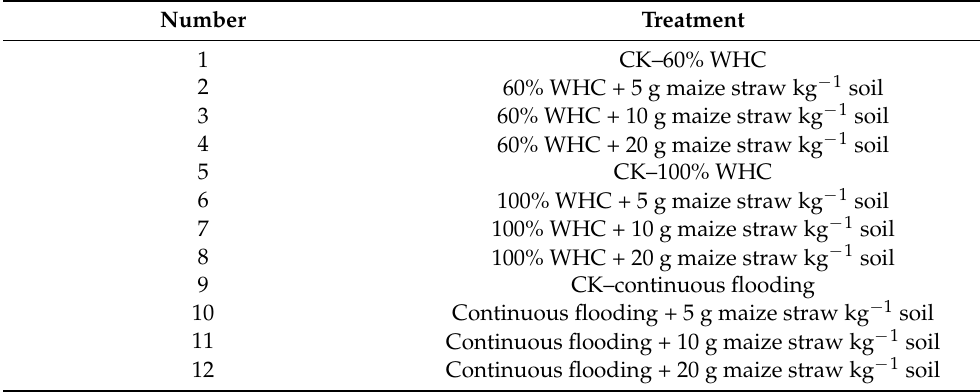
Table 2. Treatments